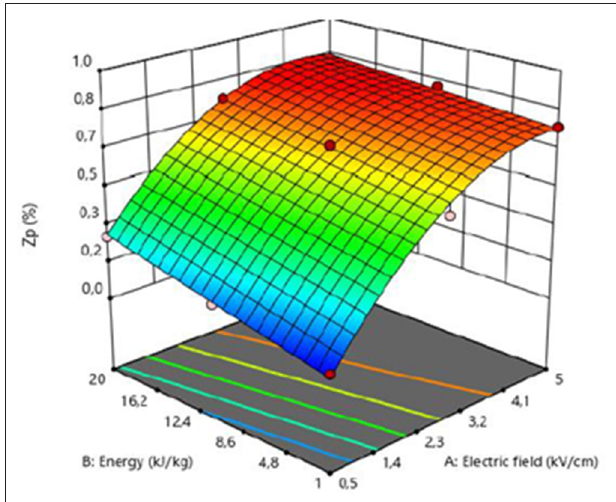
FIGURE 1 | Response surface for the permeabilization index (Zp) of PEF treated grape pomace tissues as a function of electric field strength (kV/cm) and the energy input